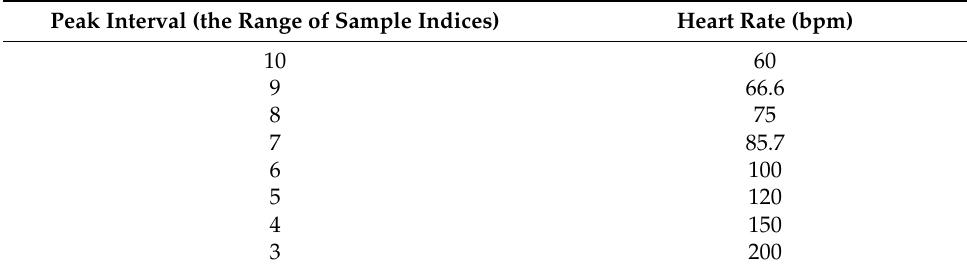
Table 4. A fuzzy rule-based model.